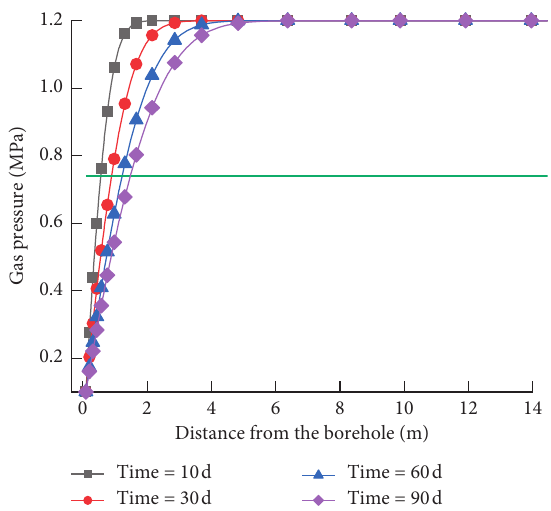
Figure 9: Gas pressure change curve when extracting gas from the borehole with 94 mm diameter. Table 4: The equivalent aperture of per unit coal